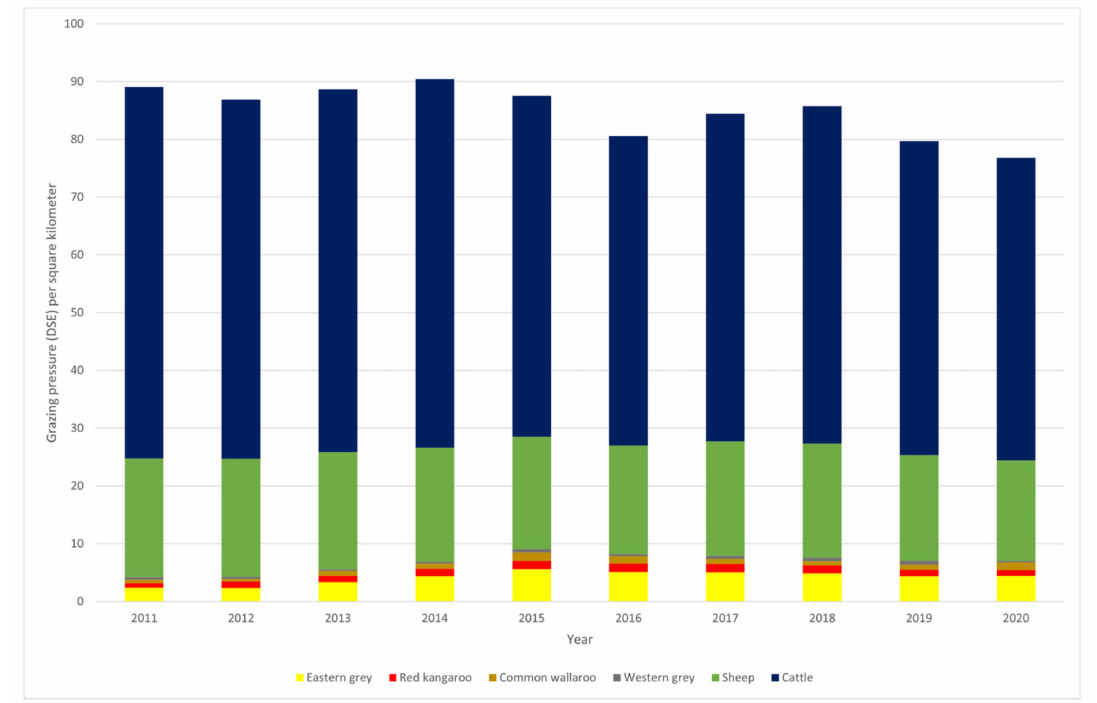
Figure 3. An estimate of annual grazing pressure by cattle, sheep, eastern grey kangaroos, red kangaroos, common wallaroos and western grey kangaroos based on stocking rate equivalents (DSE) per km 2